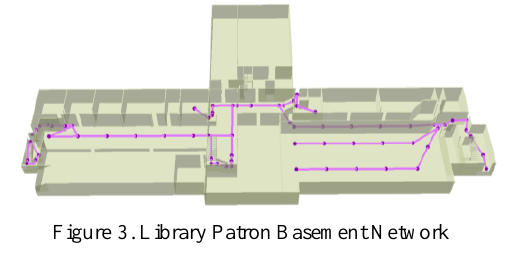
Figure 7. Library Patron Second Floor Network